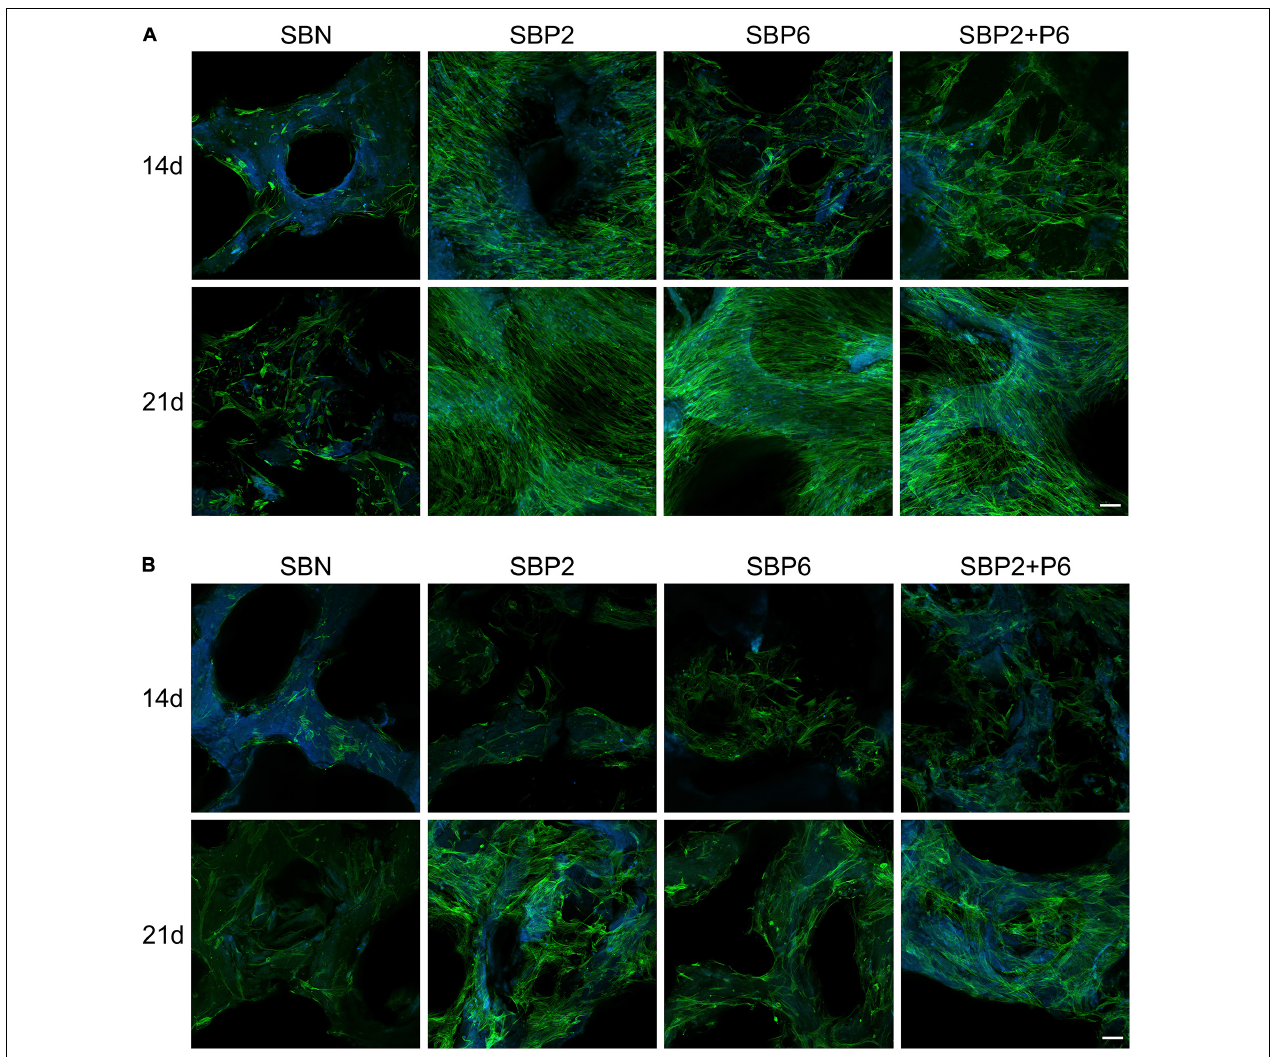
FIGURE 3 | Cell behavior of human mesenchymal stem cells (hMSCs) with growth medium (A) and in differentiation medium (B) stained with phalloidin (green) and DAPI (blue) observed under laser scanning confocal microscopy. Scale bar: 100 µ m ( n =